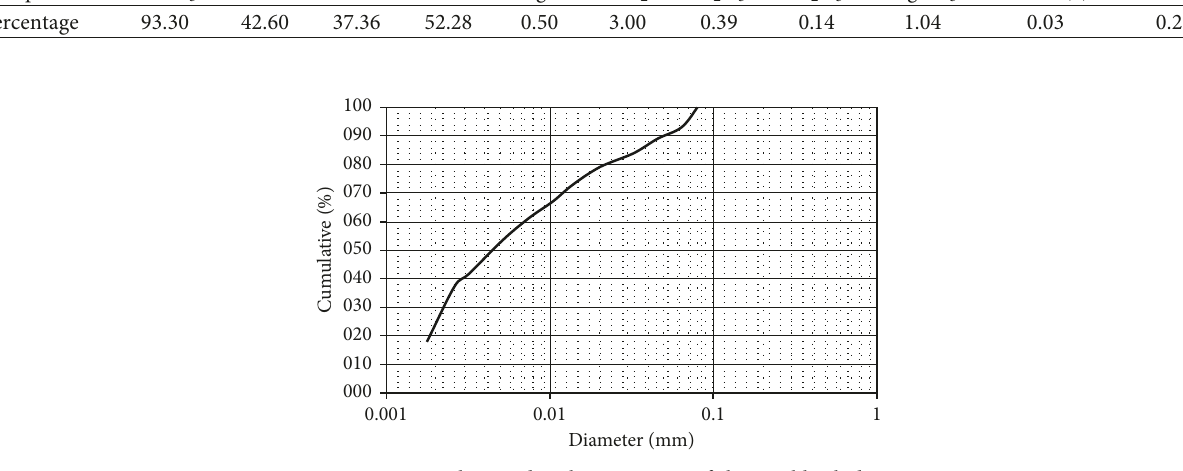
Figure 1: Particle-size distribution curve of the marble sludge. Table 2: Atterberg limits of the marble sludge.